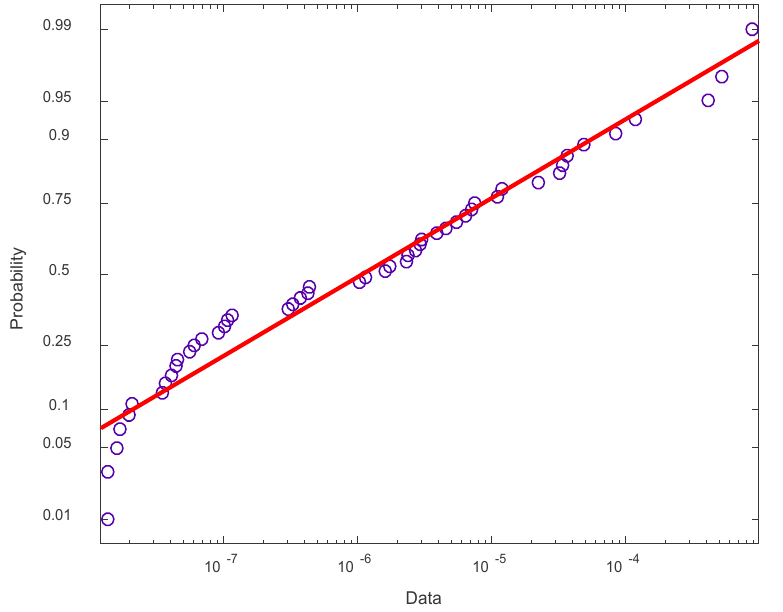
Figure 11. Values of dependent variable ∑(1/N i ) for stirrups in Lognormal probability paper considering limited prestressing and ADTT =